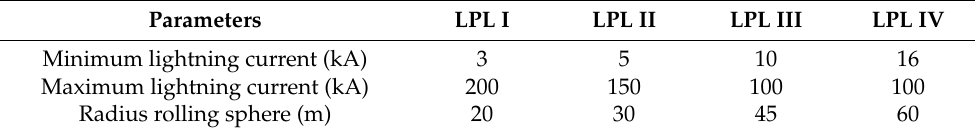
Table 1. Lightning protection level (LPL) relating to radius of rolling sphere as per IEC 62305. Parameters LPL I LPL II LPL IV Minimum lightning current (kA) Maximum lightning current